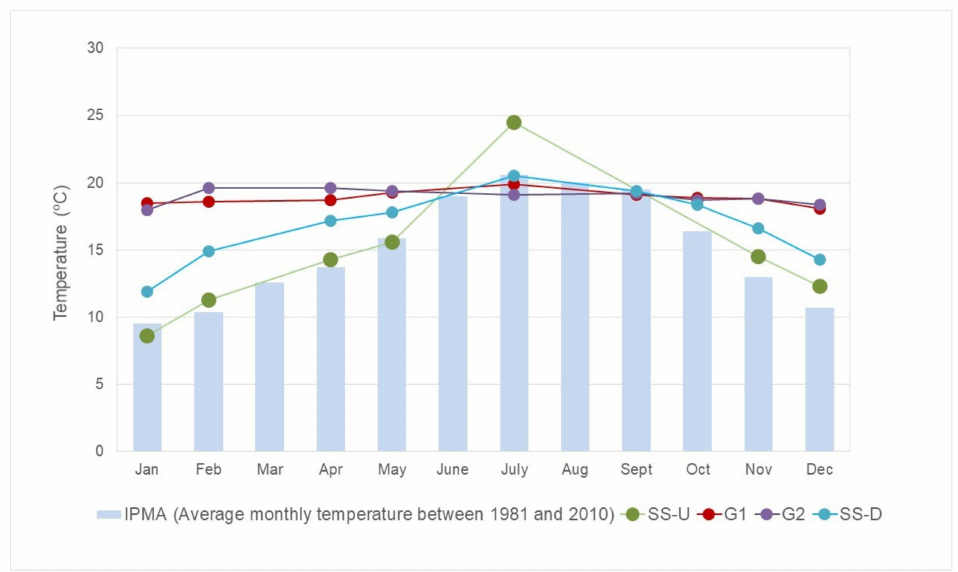
Figure 3. Average monthly air temperature measured between 1981 and 2010 in Serra do Pilar weather station (IPMA). Water temperature recorded at the sampling points SS-U, G1, G2 and SS-D on April, June, October and December 2017, January and November 2018, and February, May, September and December